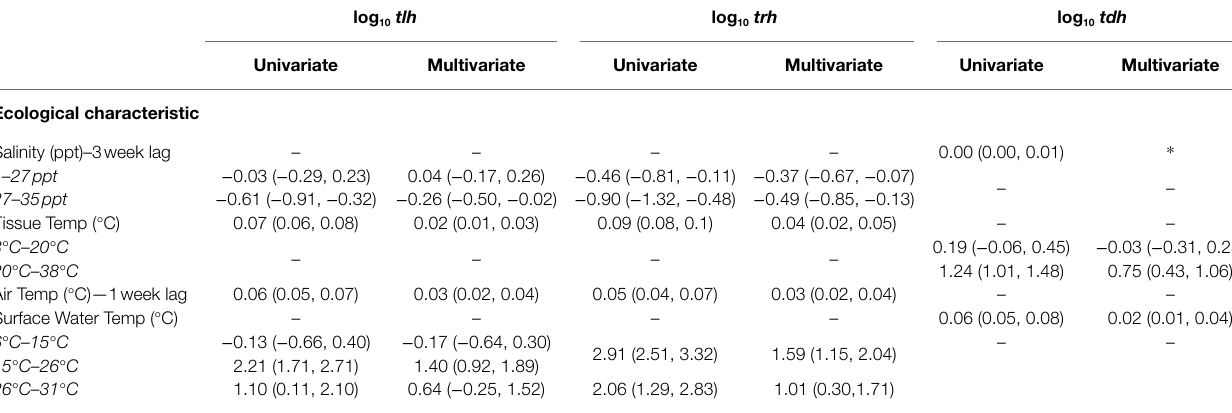
TABLE 2 | Fixed effect estimates from univariate and multivariate regression models of tlh , trh , and tdh with environmental covariates. log 10 tlh log 10 trh Univariate